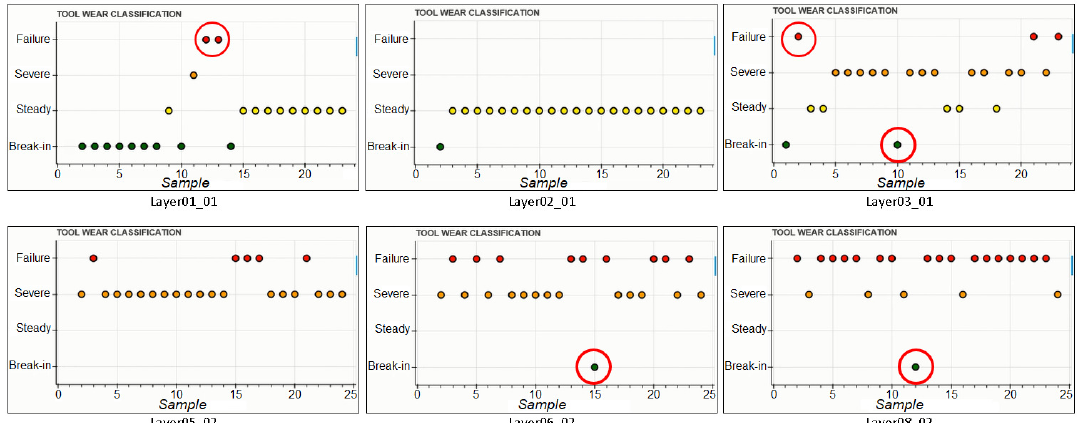
Figure 10. Representative examples of the online tool wear classification. Classes are colour coded as green for Break-in , yellow for Steady , orange for Severe and red for Failure , whereas values along the x -axis denote the number of passes for the current